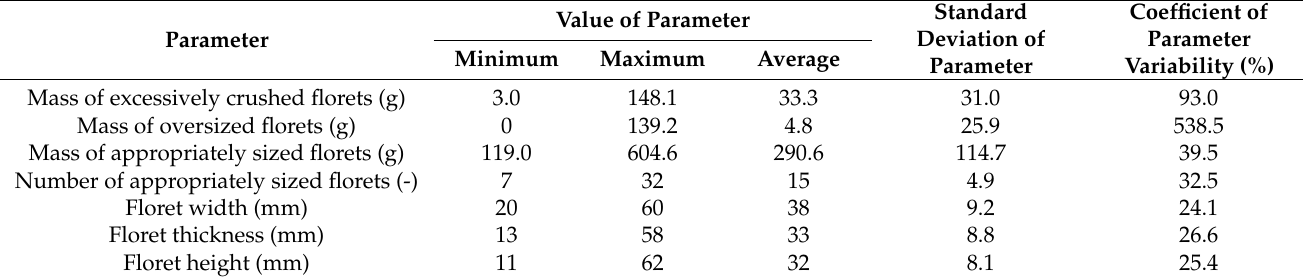
Table 2. Statistical distribution of floret